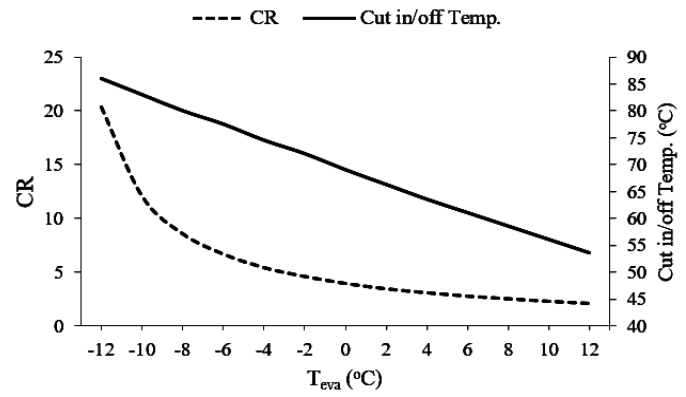
Figure 20. Effect of T eva on the CR and cut in/off temperature.